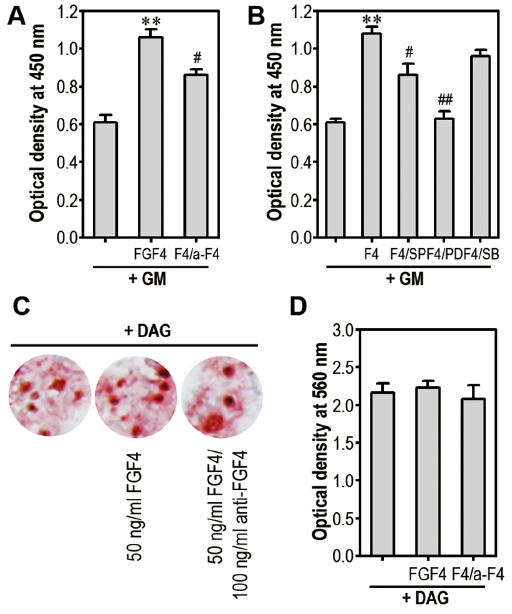
Figure 9. FGF4 stimulates proliferation of mBMMSCs via activation of MAPK. mBMMSCs were incubated with 50 ng/ml FGF4 and/or 100 ng/ml (A), or each of MAPK inhibitors (B) in 96- multiwell plates. After 48 h, these cells were processed for cell proliferation assay. **p , 0.01 vs. GM alone. # p , 0.05 and ## p , 0.01 vs. FGF4 treatment alone. (C) mBMMSCs were incubated in the presence of DAG with and without 50 ng/ml FGF4 and 100 ng/ml anti-FGF4 for 14 days and were then stained with Alizarin red. (D) The absorbance of the dye was measured at 560 nm.